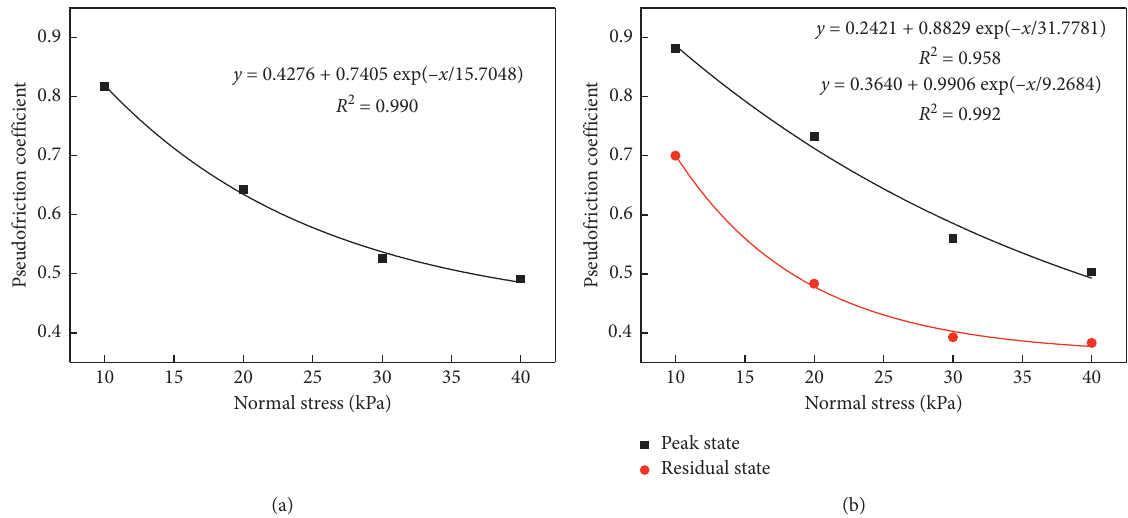
Figure 6: Relationship between the pull-out pseudofriction coefficient and normal stress: (a) geogrid and (b)